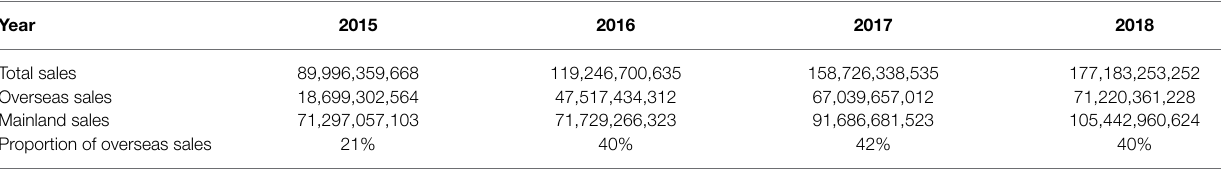
TABLE 8 | Proportion of overseas sales in Haier’s sales revenue from 2015 to